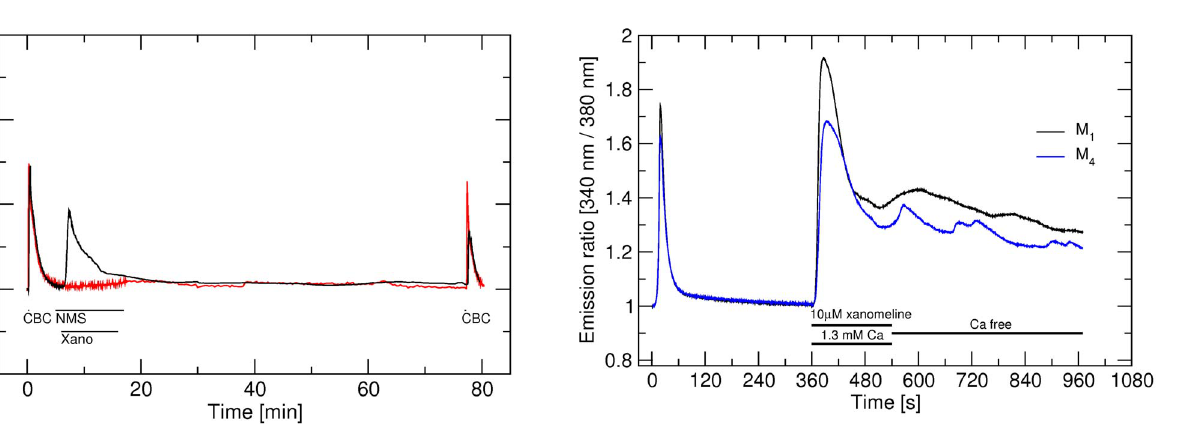
Figure 6. Effects of NMS on the formation of xanomeline wash- resistant action at hM 5 receptors. Changes in the concentration of intracellular calcium (ordinate) are expressed as changes in normalized fluorescence intensity (340 nm/380 nm) ratio normalized to basal calcium level. Red trace: First stimulation: Control 5-s stimulation with 300 nM carbachol (CBC) was performed. Second stimulation: At 5 min receptors were blocked by 10 m M of the antagonist NMS (1 min), then a mixture of 10 m M xanomeline (Xano) and 10 m M NMS was applied for 10 min and finally 10 m M NMS wash- applied for an additional 1 min. Third stimulation: After washing of the cells with KHB for 60-min 300 nM carbachol was applied for 5 s. Black trace: Control curve, same as red one but NMS was not applied. Representative traces are averages of 8 to 12 best responding cells from one experiment. Signal variation (SD) among cells ranges from 6 0.015 at the base line to 6 0.032 at peaks. Results were confirmed in 5 additional independent experi- ments.